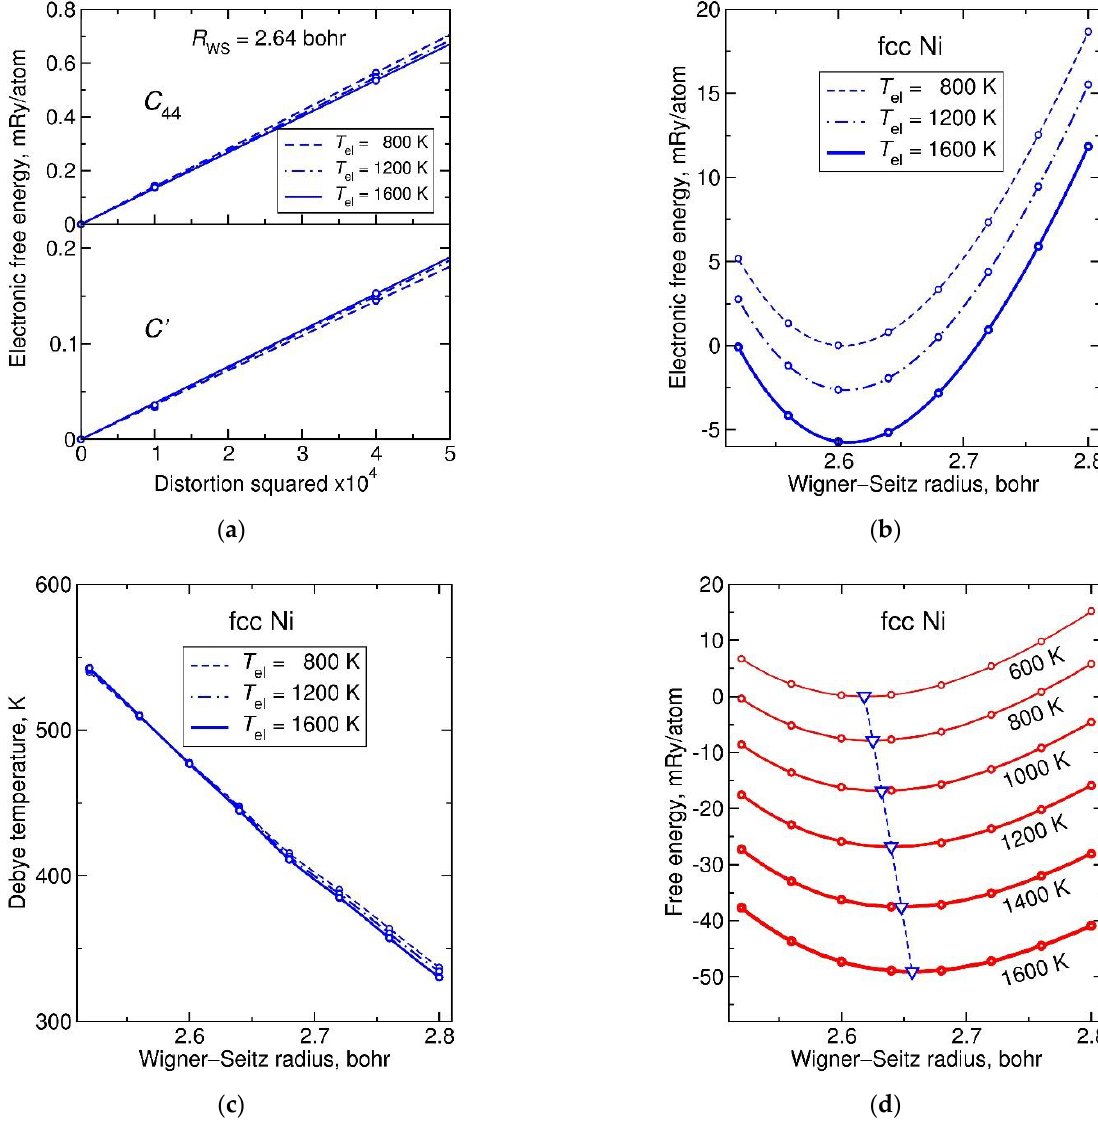
Figure 2. Parameterization of the Debye model using elastic property calculations for paramagnetic fcc Ni, a metal with an open d -electron shell: ( a ) electronic free energy dependencies on two shear distortions, to calculate 𝐶 44 and 𝐶′ at each considered 𝑅 WS and 𝑇 el ; ( b ) electronic free energy dependence upon isotropic strain, to calculate adiabatic bulk modulus 𝐵 el (𝑉 , 𝑇 el ) ; ( c ) Debye temperature estimated from 𝐶 44 , 𝐶′ , and 𝐵 el ; ( d ) Helmholtz free energy obtained by adding the vibrational free energy in the Debye model to the electronic free energy. Dashed line with down triangles indicates the temperature-dependent equilibrium volume.